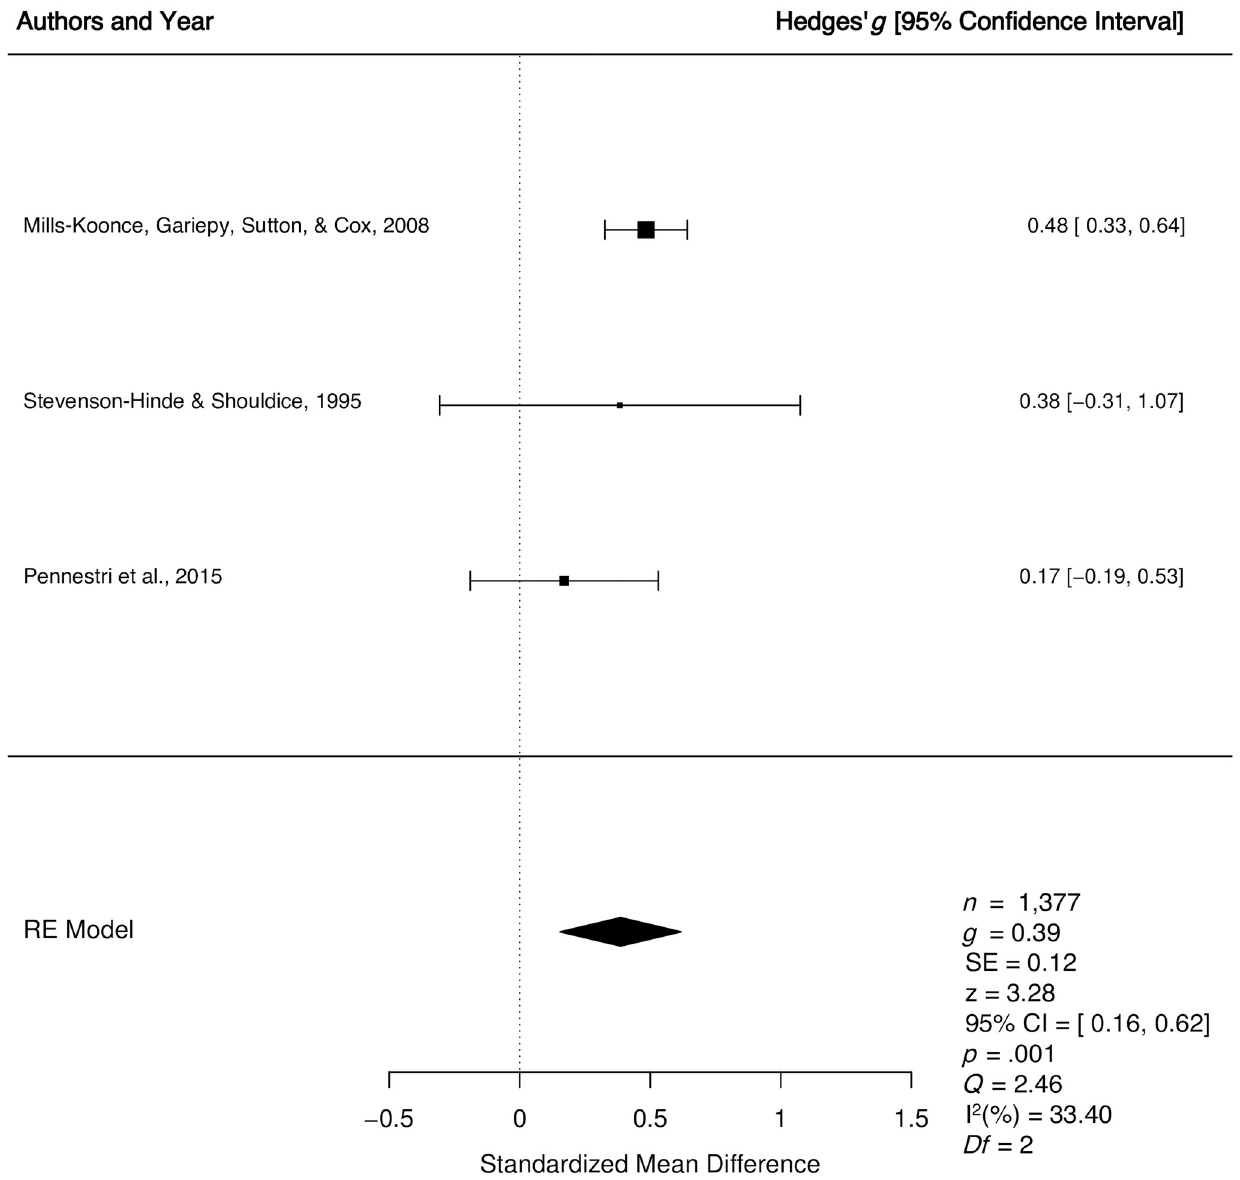
Fig 6. Forest plot for the longitudinal relationship between multidimensional caregiver sensitivity and organized versus disorganized preschool attachment. RE = Random Effects Model; g = Hedges’ g; Q = Cochran’s heterogeneity statistic; I 2 = percentage of variability across studies that is due to between-study